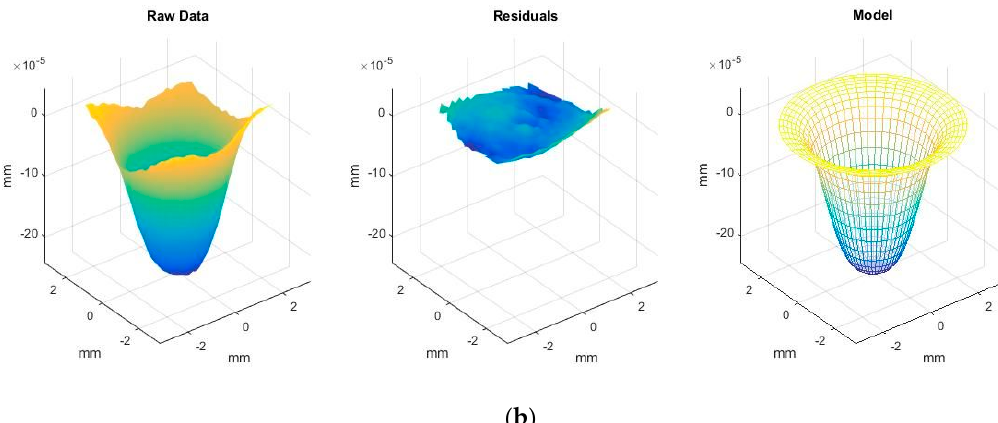
Figure 7. Tool influence function (TIF) fitting results comparison—FEM R10 tool ( a ); VEH R10 tool in the dynamic mode ( b ).